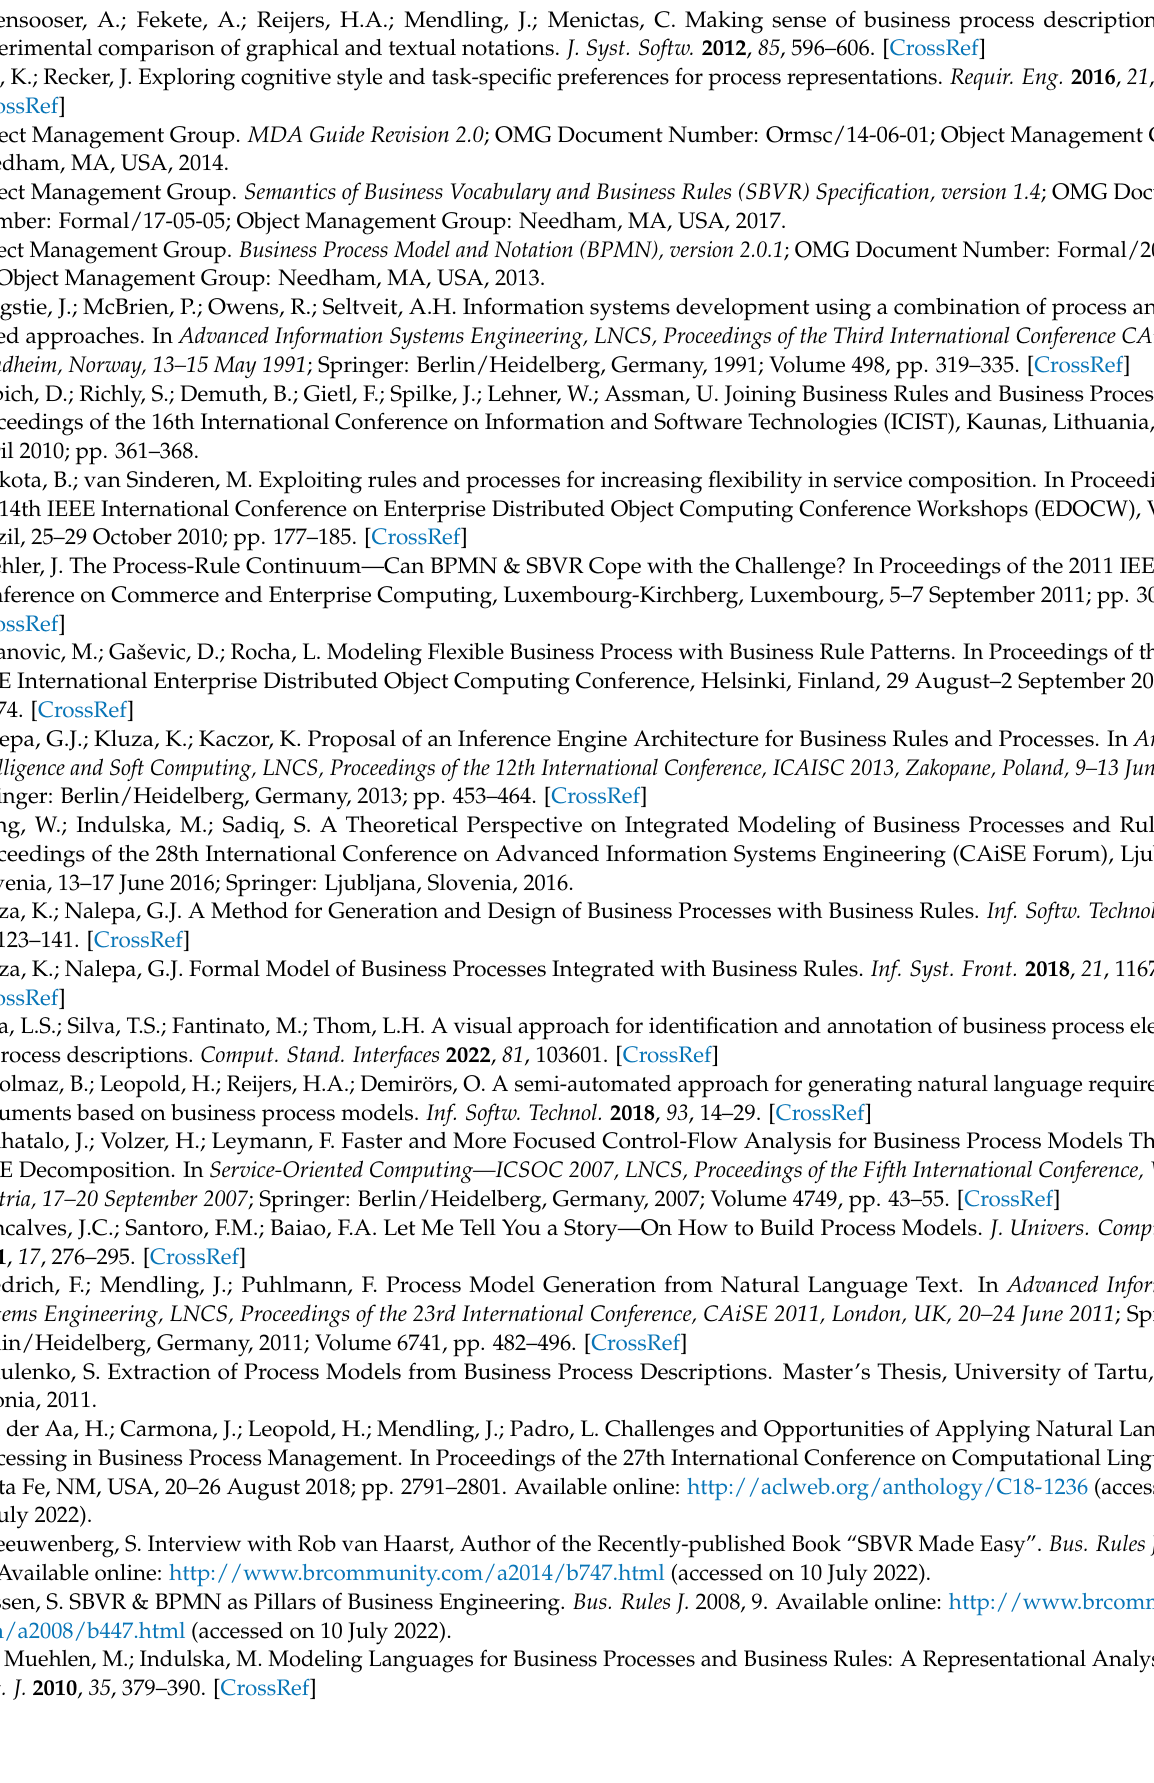
Figl, K.; Recker, J. Exploring cognitive style and task-specific preferences for process representations. Requir. Eng. 2016 , 21 ,